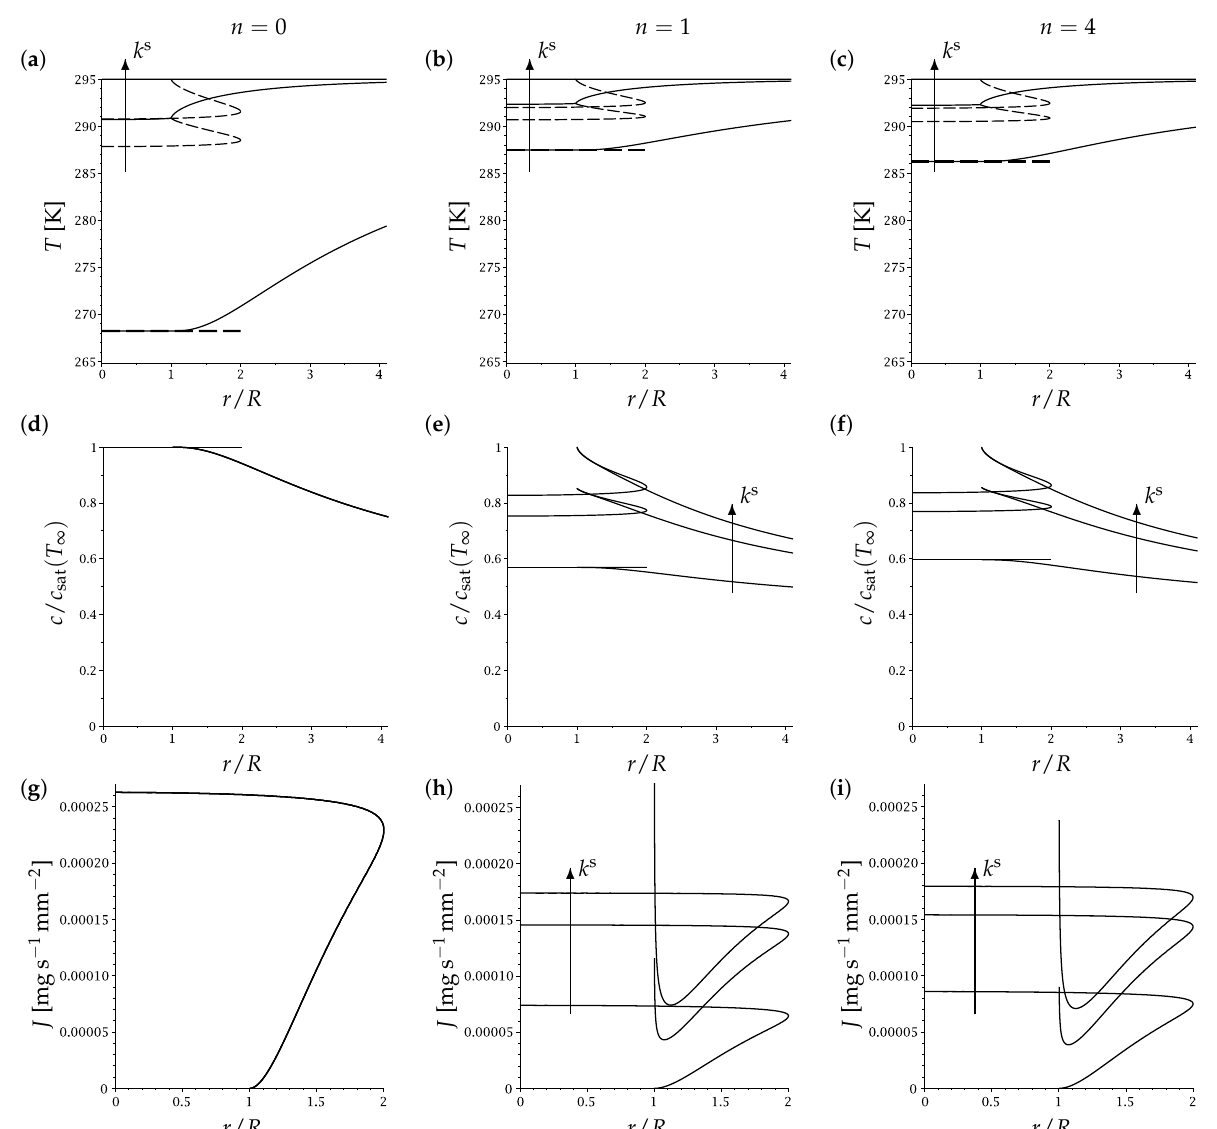
Figure 3. Vapour concentration for a droplet of water with contact angle ( a ) θ = 2 π /3 and ( b ) θ = 5 π /6 and contact radius R = 0.5 mm evaporating into air with T ∞ = 295 K on a PTFE substrate ( k s = 0.25 Wm − 1 K − 1 ). Shown also are temperature contours of T , T s and T a in K.